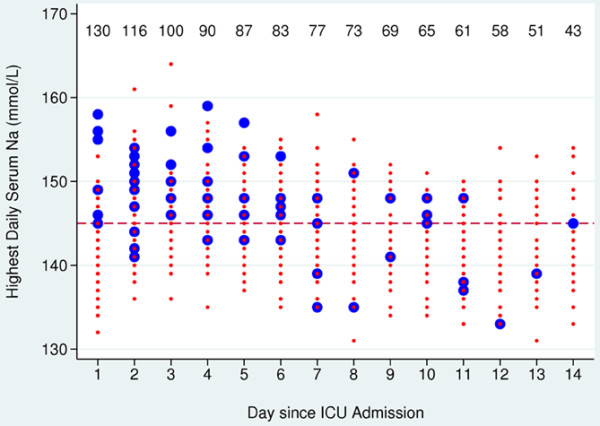
Highest daily serum sodium during the intensive care unit stay. Serum sodium (Na) values measured during intensive care unit (ICU) days when desmopressin acetate (DDAVP) was not administered (red dots) and when DDAVP was administered (blue circles). Data reported in the upper part of the plot represent the number of patients under observation on each ICU day of stay (the number decreases from left to right owing to discharge from ICU or owing to patient death). Horizontal dotted line, cut-off level of 145 mmol/l used to define hypernatremia. DDAVP was associated with higher serum Na levels (P < 0.001). The association between DDAVP and hypernatremia was not evident in the latest period of the ICU stay, possibly owing to the lowering effect of DDAVP on serum Na.